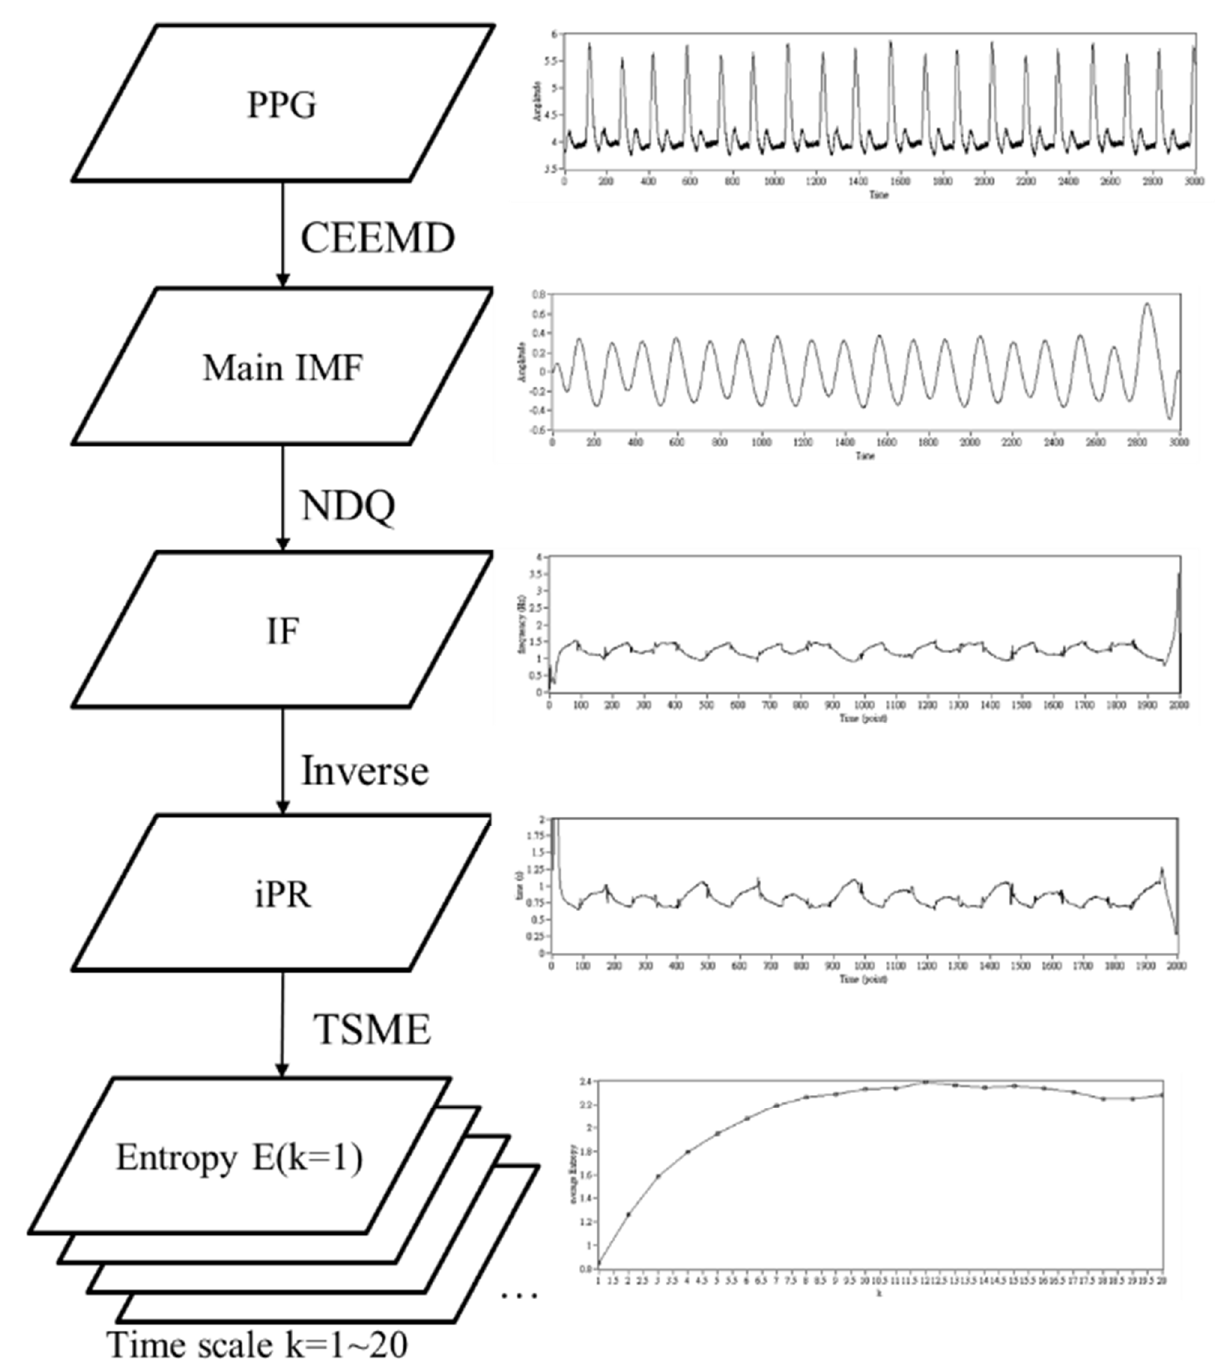
Figure 1. Demonstration of signal processing.